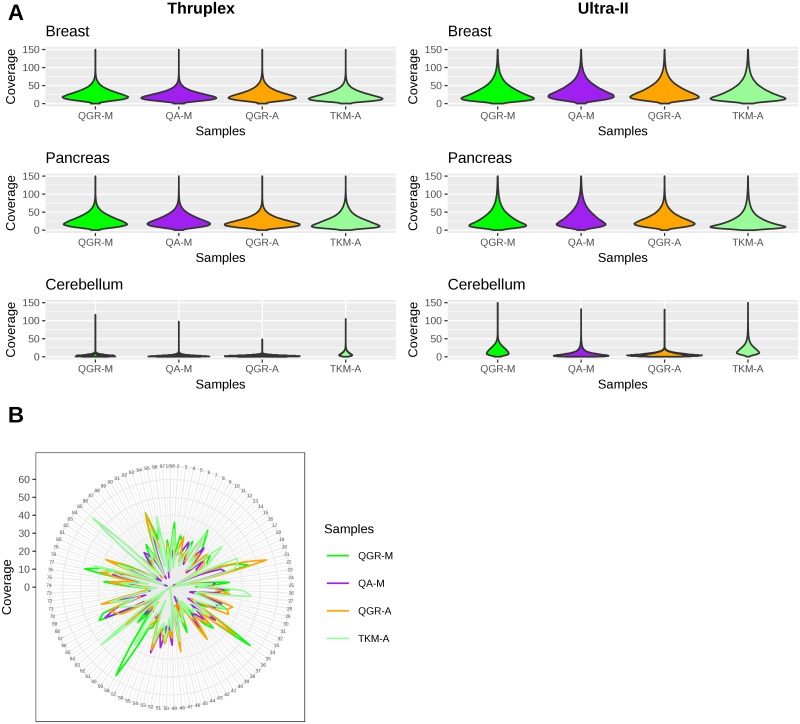
Raw coverage distribution for the four DNA extraction methods for three tissue types.A) Across all targeted bases as seen in the Thruplex (left panel) and Ultra-II (right panel) methods and B) Across a subset of the targeted regions with the Ultra II method and the Breast samples. The numbers 1–98 represent a random set of 98 target regions. The overall coverage is very similar for the four methods. The cerebellum samples show significantly lower coverage compared to other tissues due to the highly degraded nature of the samples. The CIRCOS plot the coverage lines within are noted on the left (0X the inner most to 60X the outer most concentric lines).